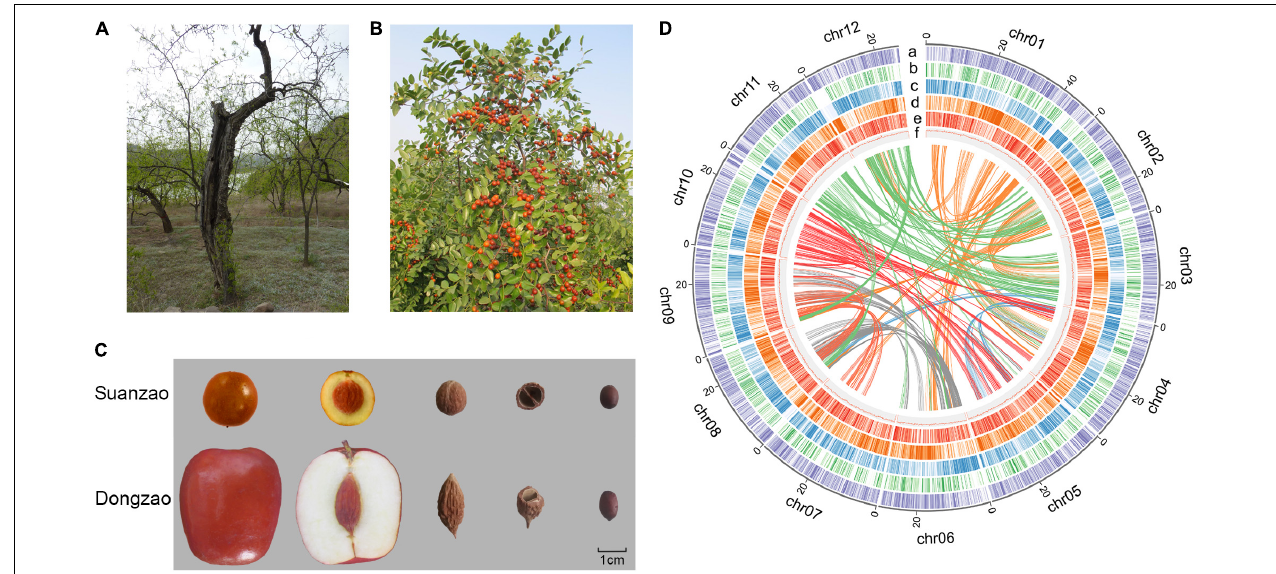
FIGURE 1 | Fruit and dried seed of Z. jujuba Mill. var. spinosa (Suanzao or sour jujube). (A) The Suanzao tree that was used for sample collection in the genome sequencing. (B) Mature Suanzao fruits on the tree. (C) Comparison of Suanzao and Dongzao ( Z. jujuba Mill.) for the fruit and seed. (D) Circular plot of the pseudomolecules in Z. jujuba Mill. var. spinosa . The coordinates of 12 pseudomolecules are shown in Mbp. The layers are placed from the outside to the inside, a: density of Copia long terminal repeat-retrotransposons (LTR-RTs); b: density of LINE LTR-RTs; c: density of genes; d: density of Gypsy LTR-RTs; e: pseudogene density; and f: GC content. Central lines connect syntenic blocks across pseudomolecules, and colors were randomly selected to represent different